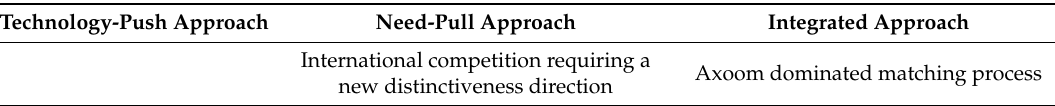
Table 6. Summary of the adoption drivers for GS